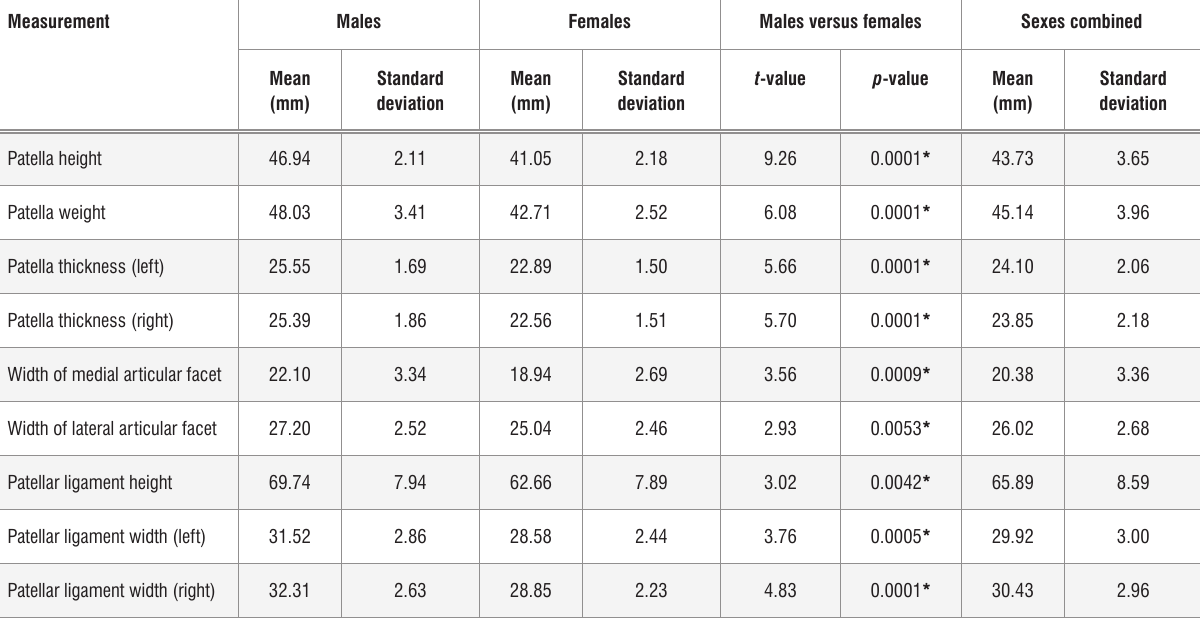
Descriptive statistics of measurements of the patella and patellar ligament